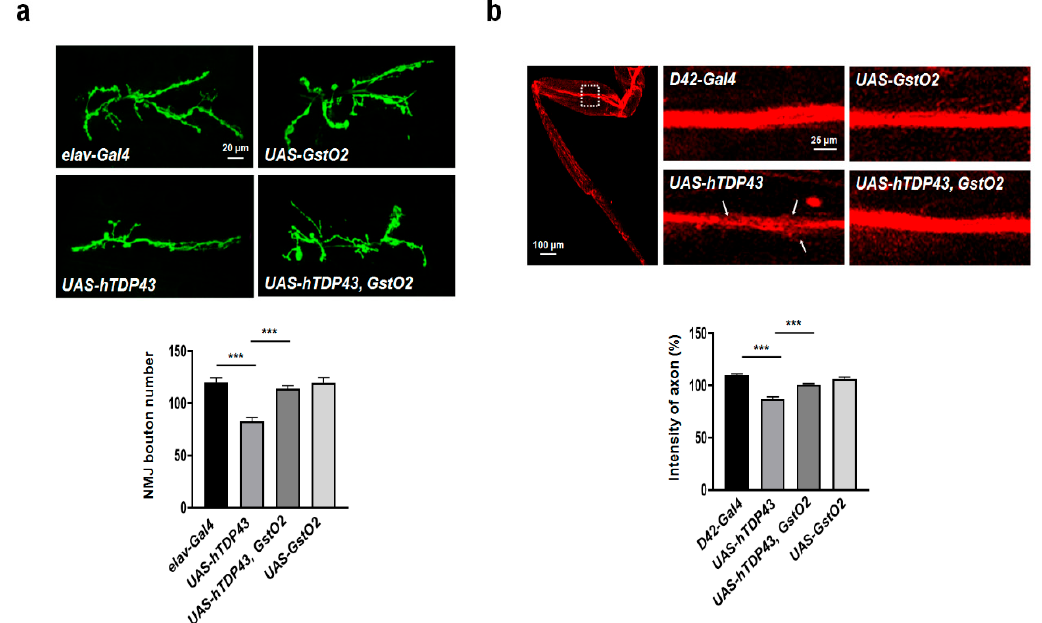
Figure 2. hTDP-43-induced degenerative motor neuron and loss of neuromuscular junction (NMJ) were suppressed by expressing GstO2. ( a ) Representation of NMJ boutons labeled with anti-HRP-FITC at muscle 6 / 7 of segment 3 and quantification of the total number of boutons. Compared with the elav-Gal4 control larvae, hTDP-43 overexpression resulted in a significant reduction in the number of boutons. In the larvae co-overexpressing hTDP-43 and GstO2, the number of synaptic boutons was restored to a number similar to that of in control larvae. The quantification of data shows a genetic interaction between hTDP-43 and GstO2 on the total number of boutons per muscle area on muscle 6 / 7 of A3. Statistical significance was determined using the unpaired Student t -test (*** p < 0.001, n > 20 for each genotypes). Error bars indicate SEM. ( b ) Representative leg axon bundles labeled with membrane-tethered red fluorescent proteins (mCD8-RFP) in motor neurons specific to the D42-Gal4 driver. The white box indicates the region used for axon images. The expression of hTDP-43 in the motor neurons of fly legs showed severe axon degeneration, denoted by white arrows. The density of mCD8 signals in the axon area of the adult fly femur (dotted box) was suppressed by GstO2 overexpression. The quantification was performed by ImageJ software and normalized to the value of the D42-Gal4 control flies. Statistical significance was determined using the unpaired Student t -test (*** p < 0.001, n > 10 for each genotypes). Error bars indicate